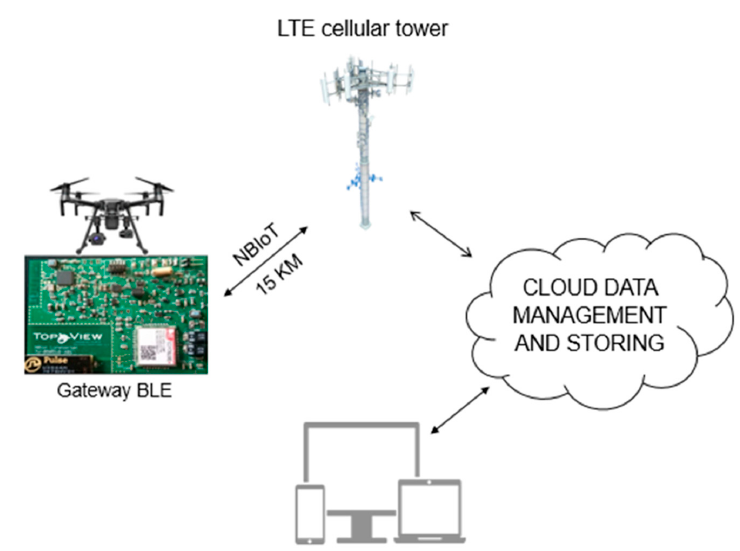
Figure 6. Schematic illustration of Data Flow from the AgriLogger gateway to the data receiver (computer, smartphone) throughout LTE cellular tower.